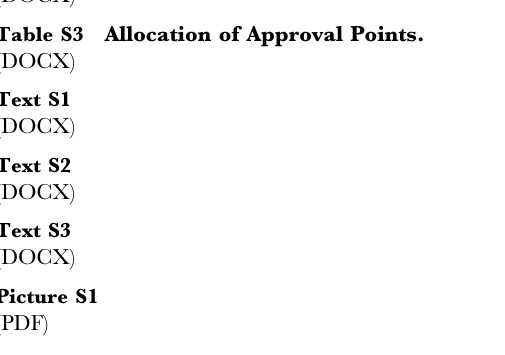
Table S3 Allocation of Approval